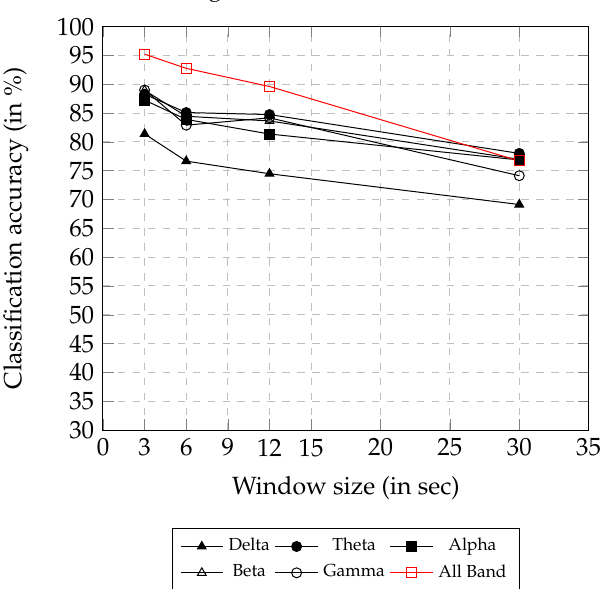
Figure 6. Arousal classification accuracy on varying window size using AsMap+CNN features. The four-class classification accuracy using AsMap+CNN on different frequency bands and window sizes are presented in Figure 7. Similar to the observations in two-class and three-class classification, it was observed that the window size has a negative impact on classification accuracy. Using AsMap+CNN features on ALL BAND, the classification accuracy remained above 85% for window sizes smaller than or equal to 12 s. However, the classification accuracy obtained on all frequency bands showed linear degradation, and the accuracy remained above 55% until a 30 s window size. Figure 7 clearly shows that AsMap+CNN features on ALL BAND together have greater discriminating ability compared to other bands for complex classification problems having four